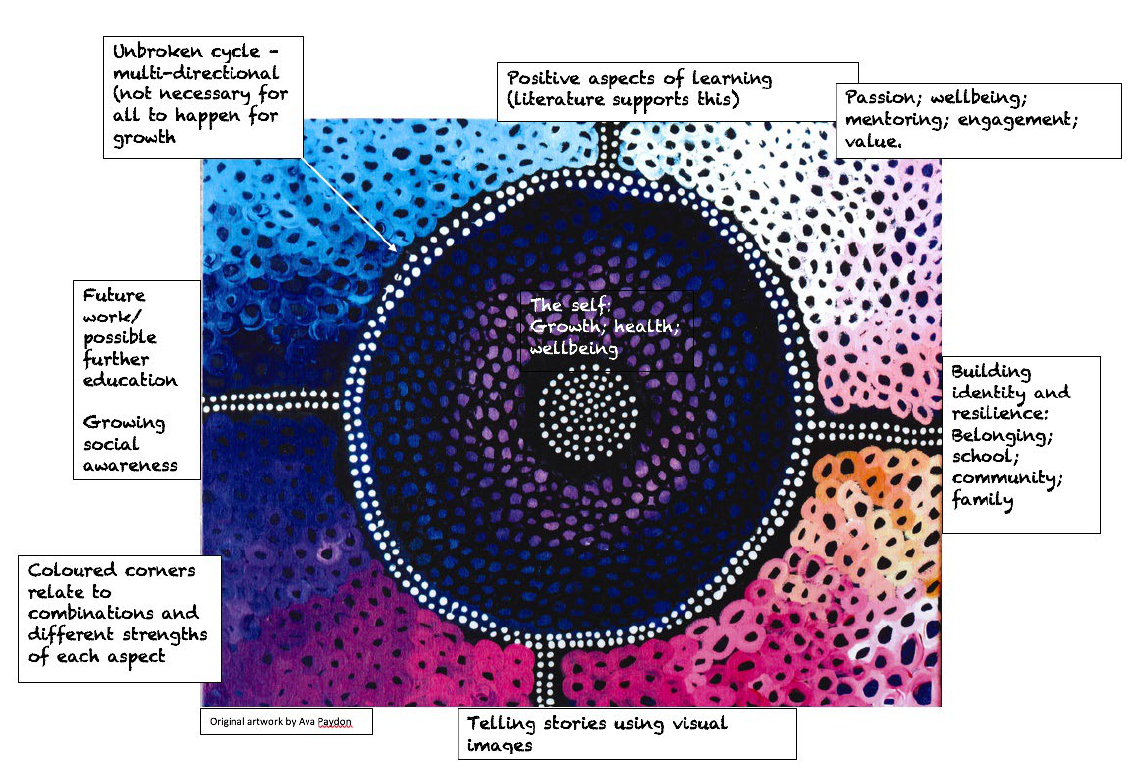
Figure 1. Arts-Based Learning